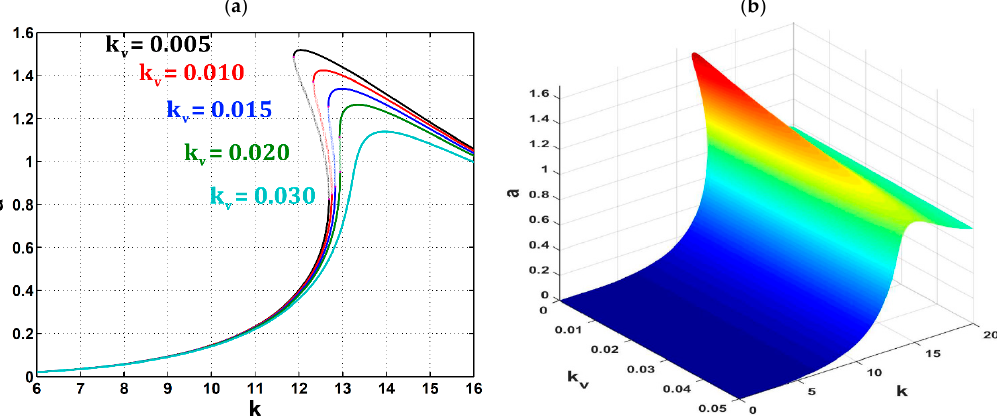
Figure 12. Relationship between the car’s oscillation amplitude (cid:1853) and ( a ) the excitation amplitude (cid:1863) at different values of NV control gain (cid:1863) (cid:3049) , ( b ) both the excitation amplitude (cid:1863) and NV control gain (cid:1863) (cid:3049) post-control ( (cid:1863) (cid:3043) = 0.6 ).